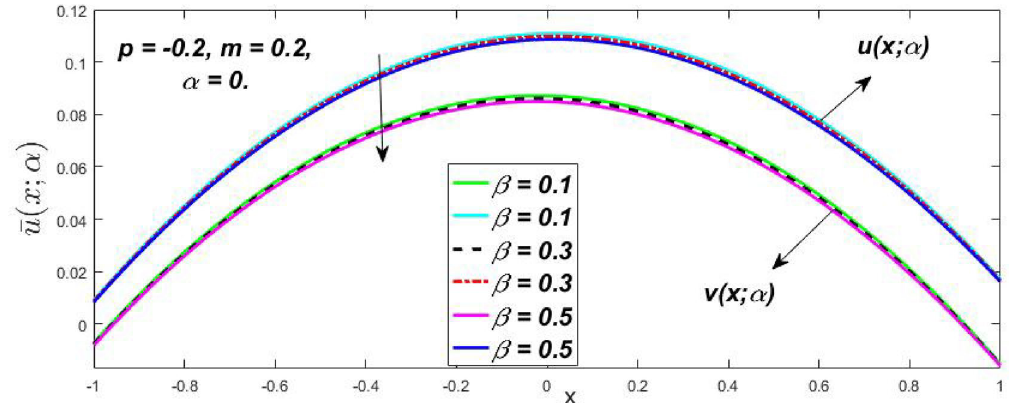
Figure 14. Fuzzy velocity profiles for the impact of β .